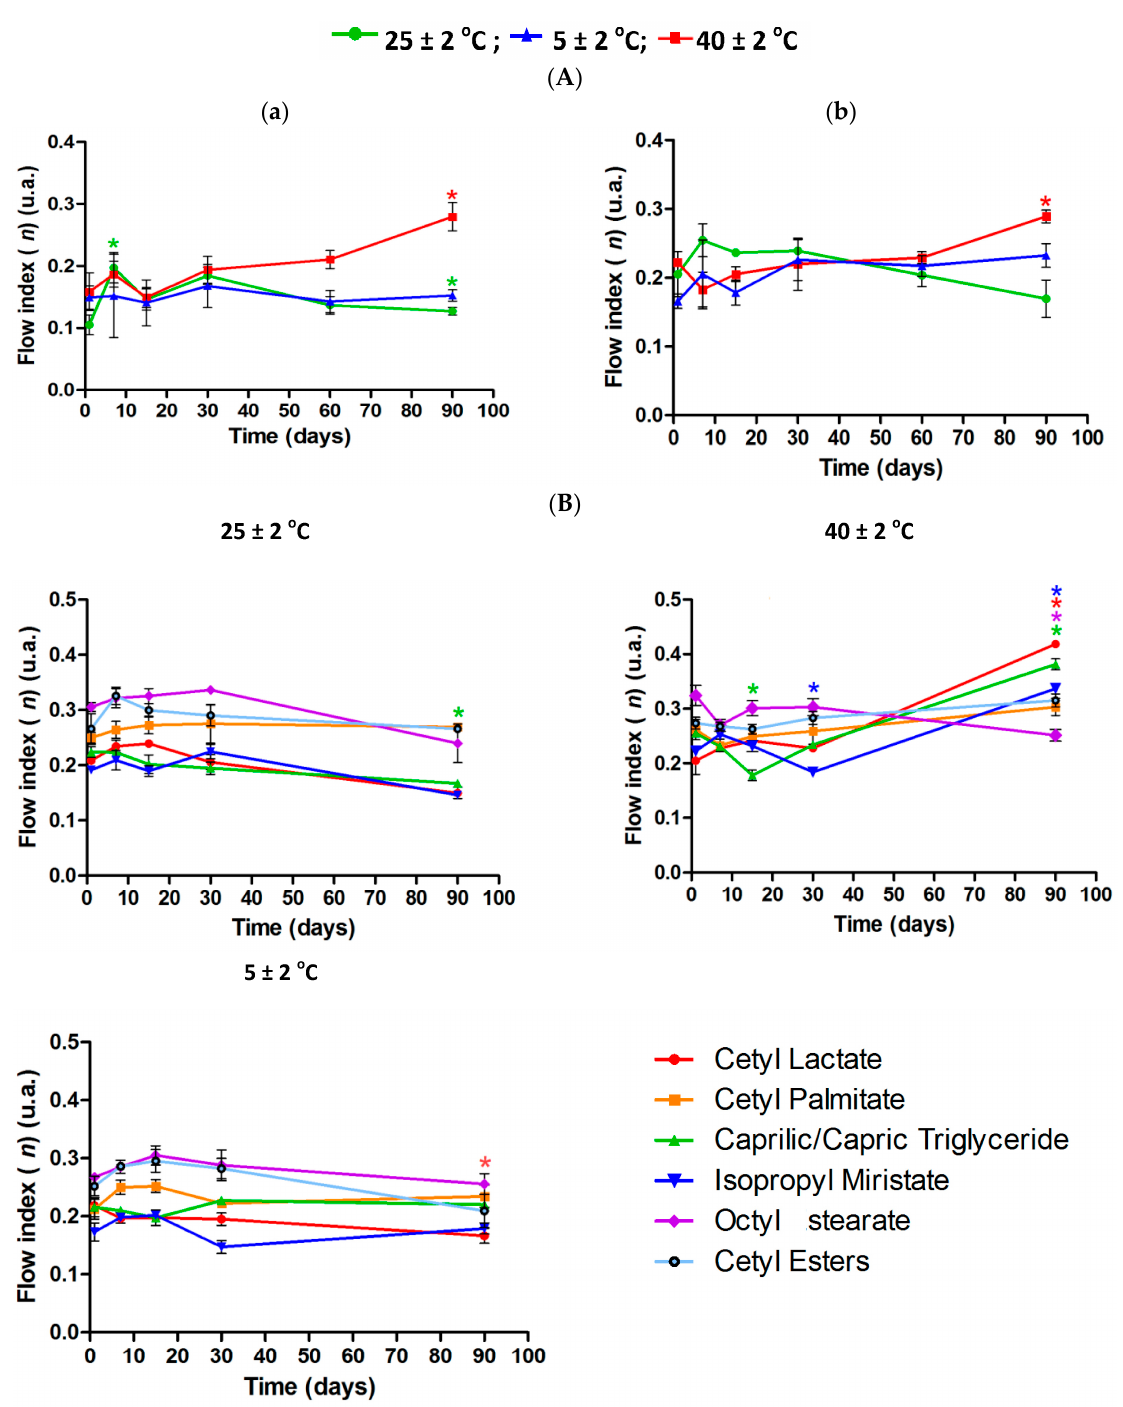
Figure 9. Flow index for 6.5 ( a ) and 7.0 ( b ) formulations during Prolonged Stability Test ( n = 3) without ( A ) or with ( B ) fatty esters. (* Statistically significant differences were 95%, p ă